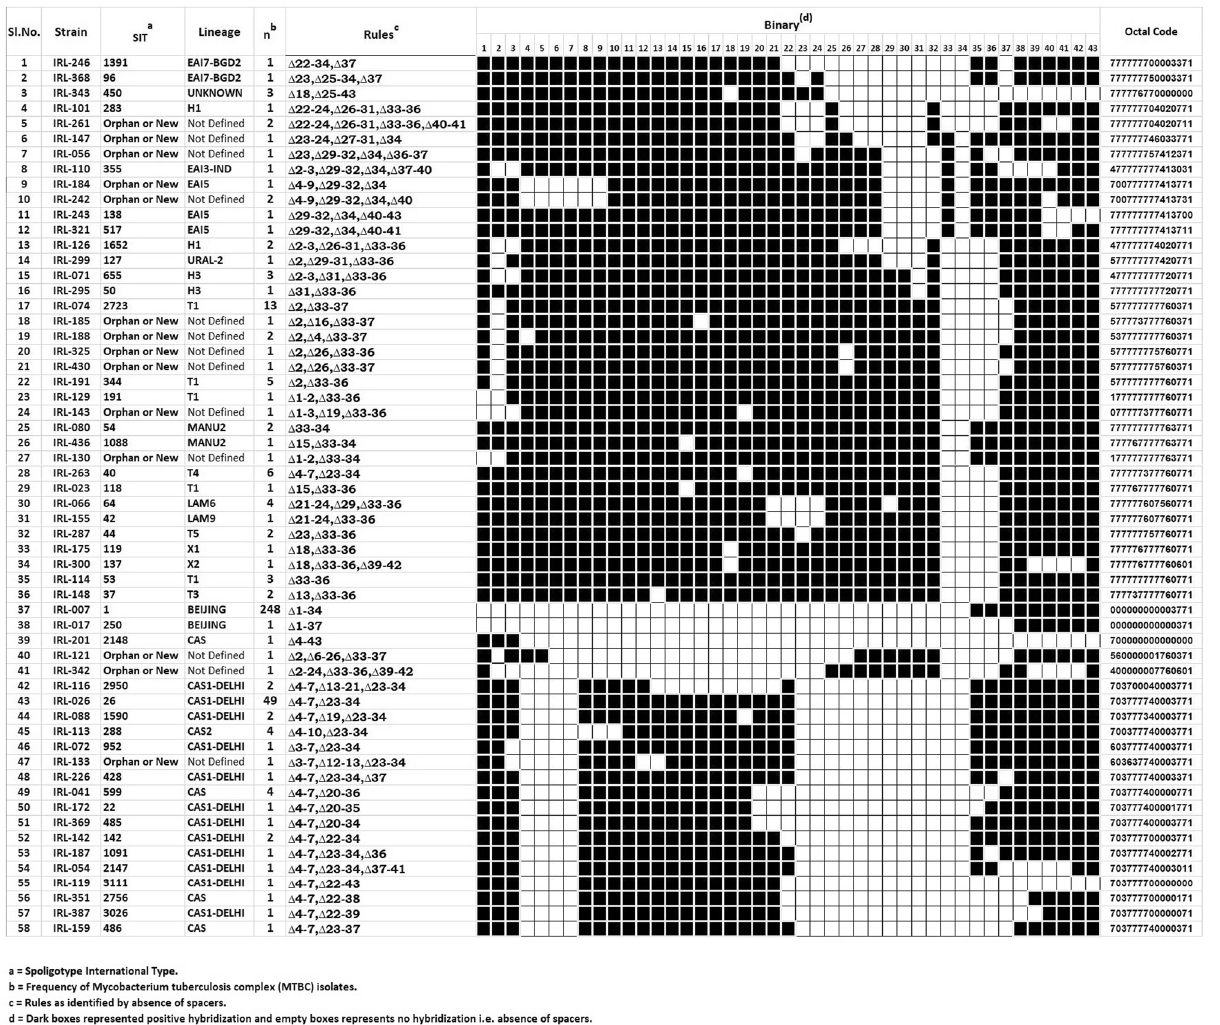
Figure 1. 58 patterns of spoligotypes of MTBC present in Sikkim (2016–2018). The spoligotype patterns are made in Microsoft Excel2019 (https:// www. micro soft. com/ en- in). We used Microsoft Windows Screenshot Snipping Tool to save as image (https:// suppo rt. micro soft. com/ en- in/ help/ 13776/ windo ws- 10- use- snipp ing- tool- to- captu re- scree